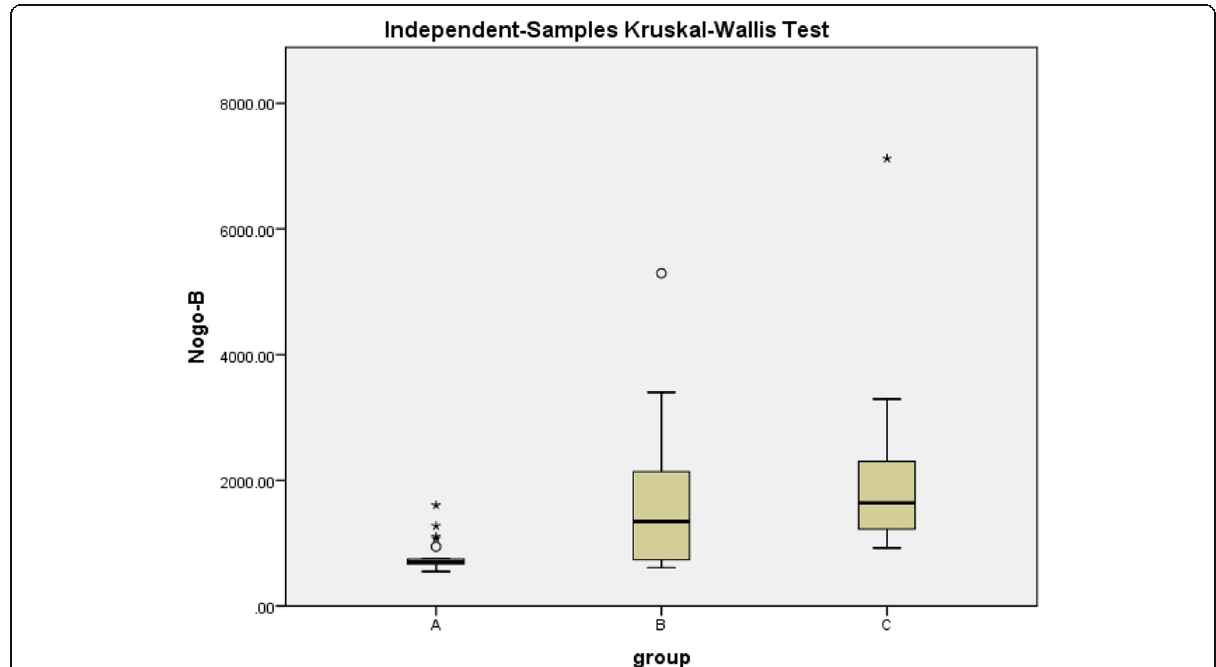
Fig. 2 Comparison between the three groups of patients as regards serum level of Nogo-B levels